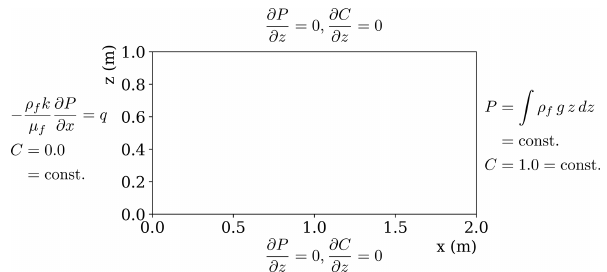
Figure 1. Model domain and boundary conditions applied to the Henry (1964) problem for numerical code validation.